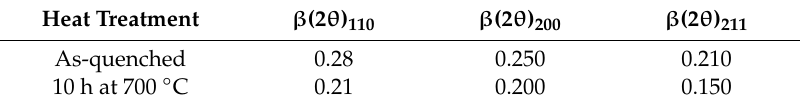
Table 3. Line breadth β (2 θ ) of the most intense X-ray diffraction (XRD) reflections.